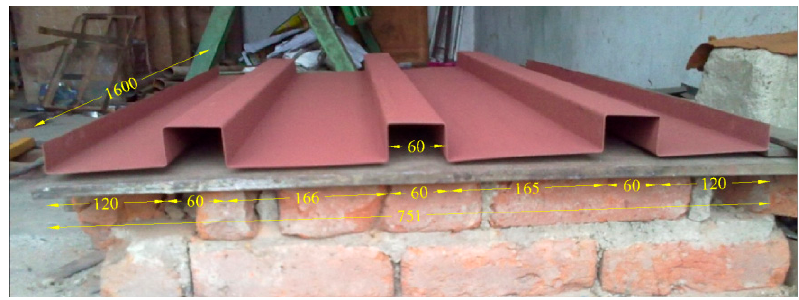
Figure 4. Rectangular profiled sheet (All dimensions are in mm).